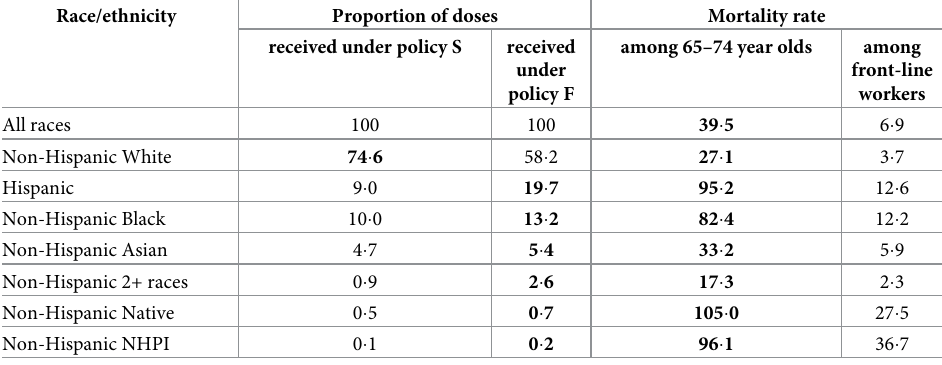
Table 2. Proportion of doses allocated under policy S and policy F , and mortality rates per 100,000 individuals for individuals 65–74 year olds and for front-line workers, per race/ethnicity categories in the United States. Race/ethnicity